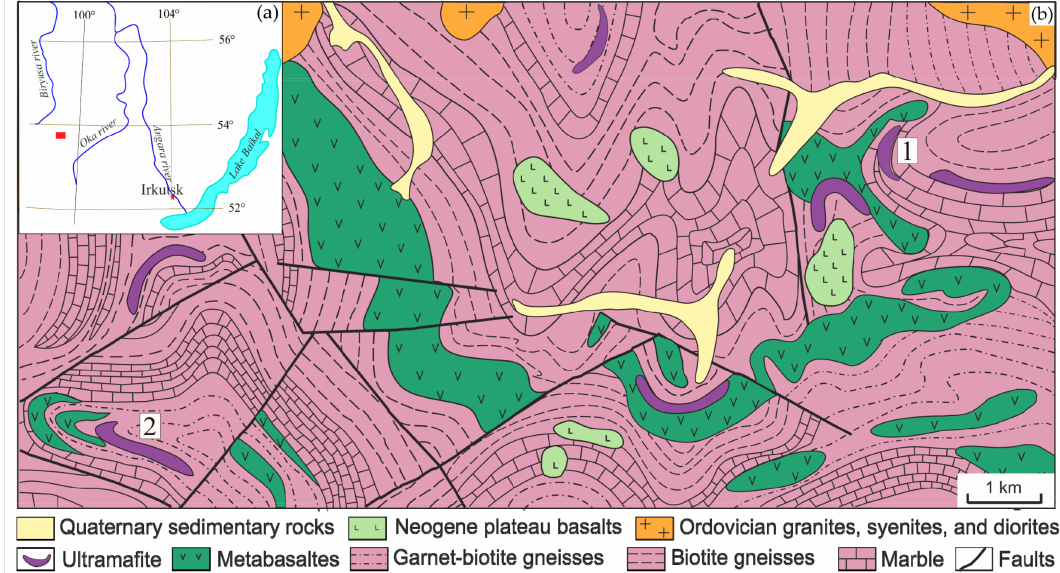
Figure 1. ( a ) A general map showing the location of the area in the Russian Federation (shown by red rectangle symbol); ( b ) geologic map of the central Iya–Kukshera interfluve, East Sayan Mountains. Digits in squares denote the Zhelos (1) and Tokty-Oi (2)